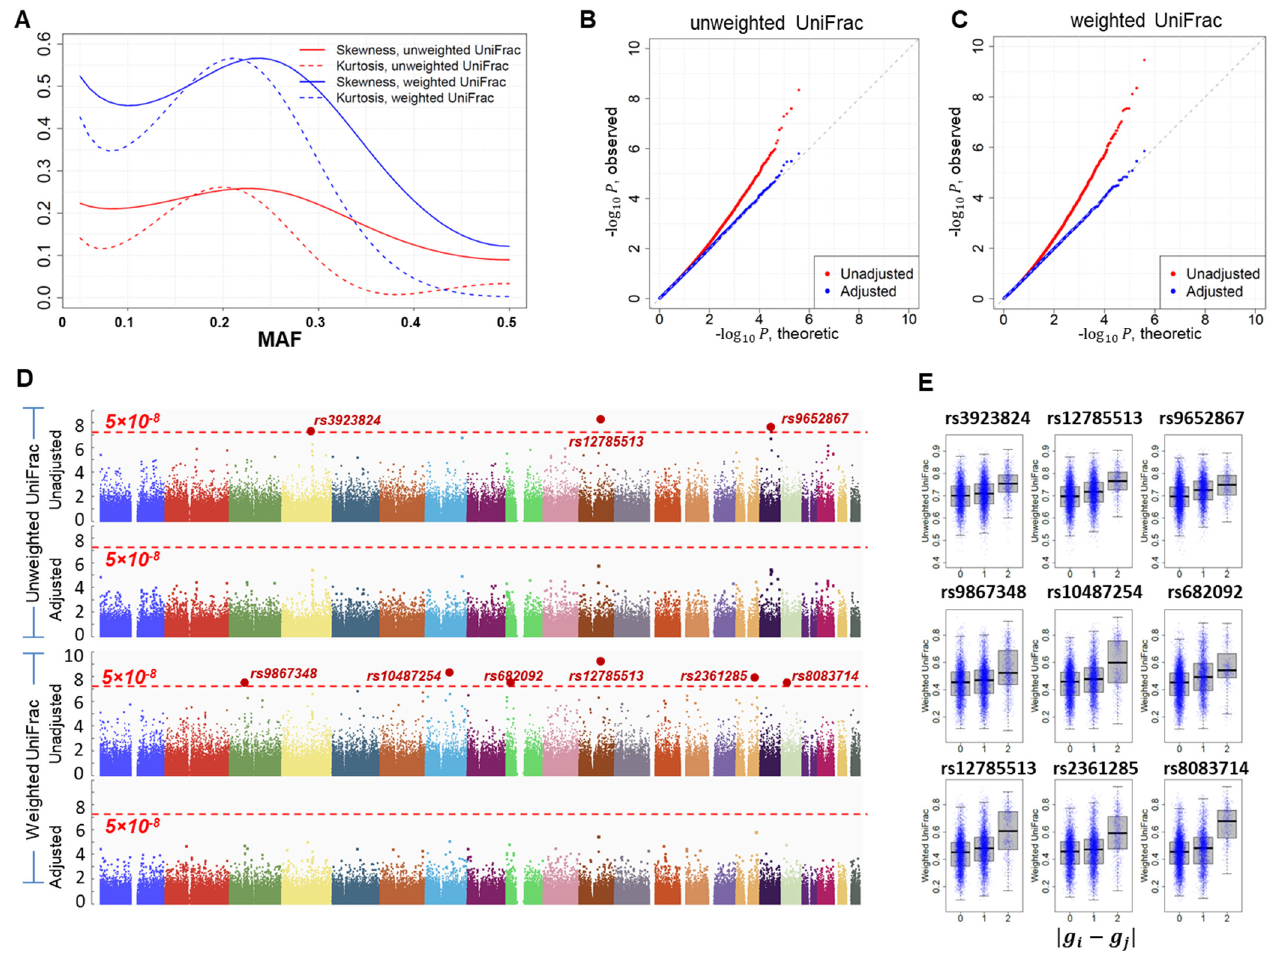
Figure 5. Results of analyzing the microbiome GWAS data of 147 adjacent normal lung tissues in the EAGLE study. ( A ) Skewness and kurtosis for the main effect test using the unweighted and the weighted UniFrac distance matrices. ( B ) Quantile–quantile (QQ) plot for association p -values using the unweighted UniFrac distance matrix. “Adjusted”: p -values were corrected for skewness and kurtosis. “Unadjusted”: p -values were approximated based on the asymptotic distribution 𝑁(0,1) . ( C ) Quantile–quantile (QQ) plot for association p -values using the weighted UniFrac distance matrix. ( D ) Manhattan plots based on the unweighted or the weighted UniFrac distance matrices. ( E ) Box plots for the top nine loci in microbiome GWAS analysis. Subject pairs are classified into three groups according to the genetic distance |𝑔 (cid:3036) − 𝑔 (cid:3037) | at the SNP. The y-coordinate is the microbiome distance.